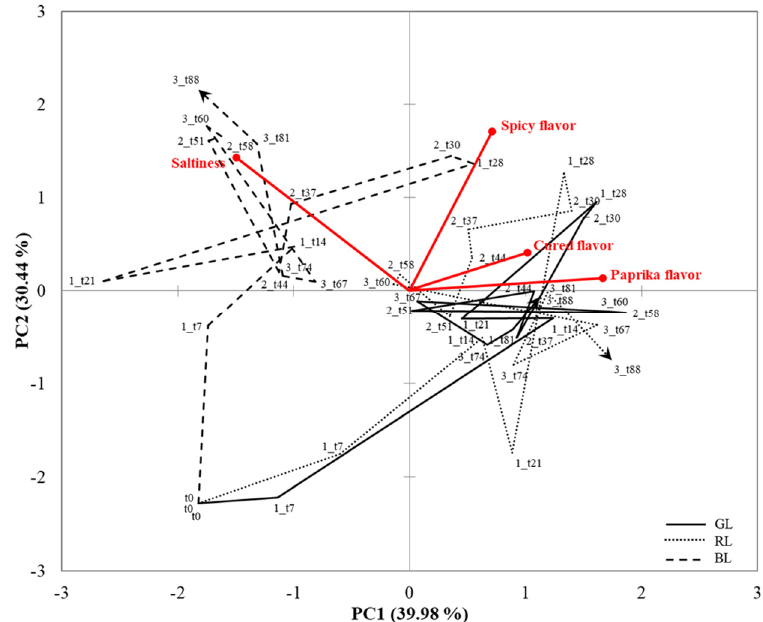
Figure 7. Principal Component Analysis representing the flavor trajectories of the dry-cured loin samples (GL = green label, Cebo de Campo Ibérico dry-cured loin; RL = red label, Bellota 50% Ibérico dry-cured loin; BL= black label, Bellota 100% dry-cured loin) over the three intakes.